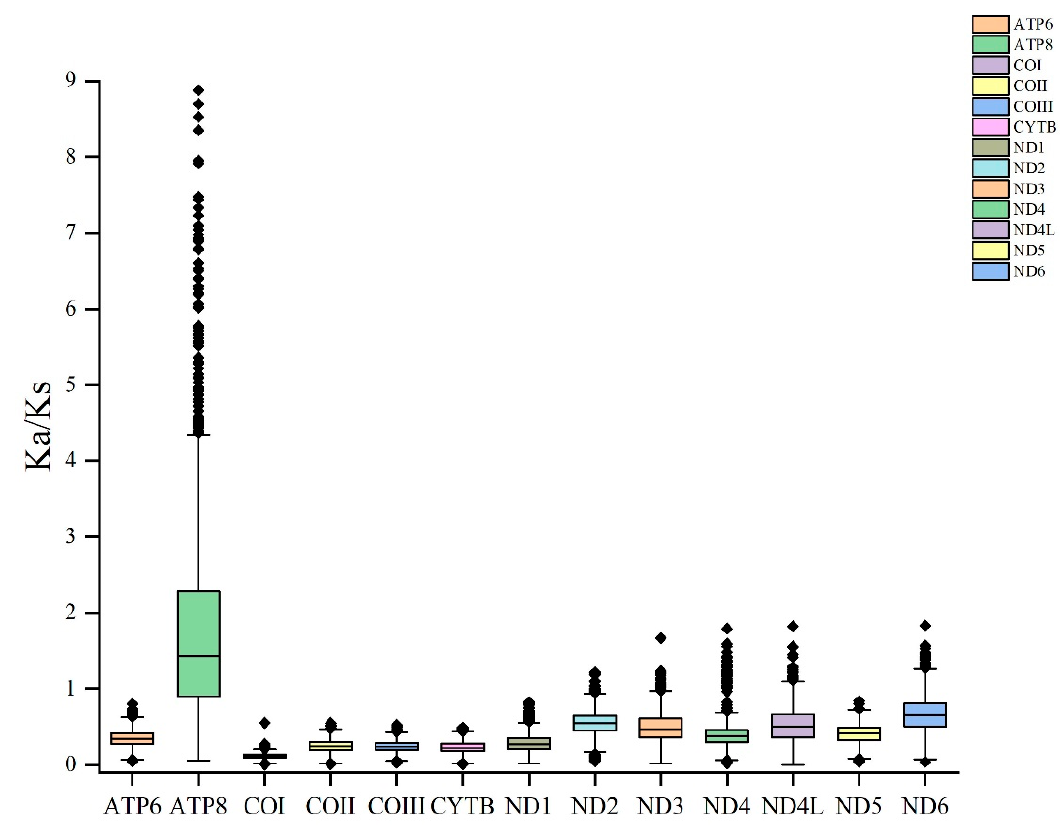
Figure 5. The Ka/Ks ratio for the 13 PCGs of 55 spider